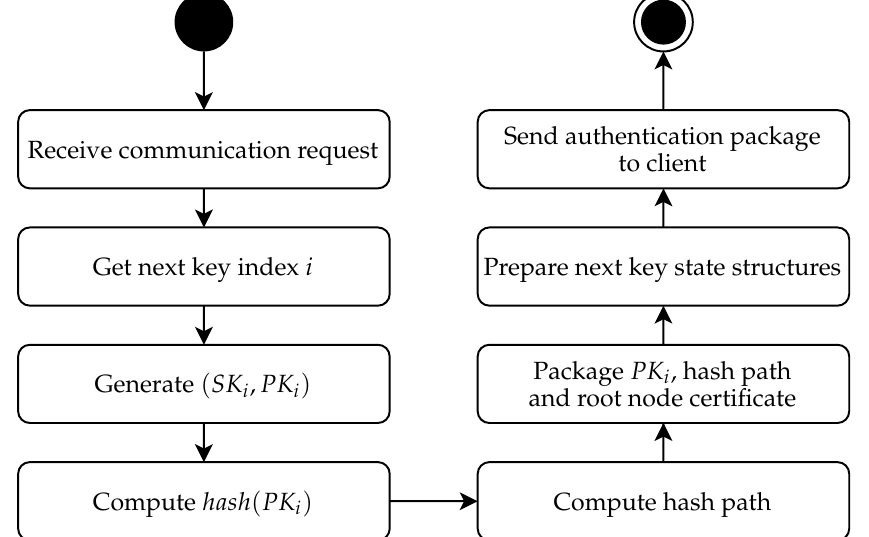
Figure 6. Update of the authentication path for the next ephemeral key on the server